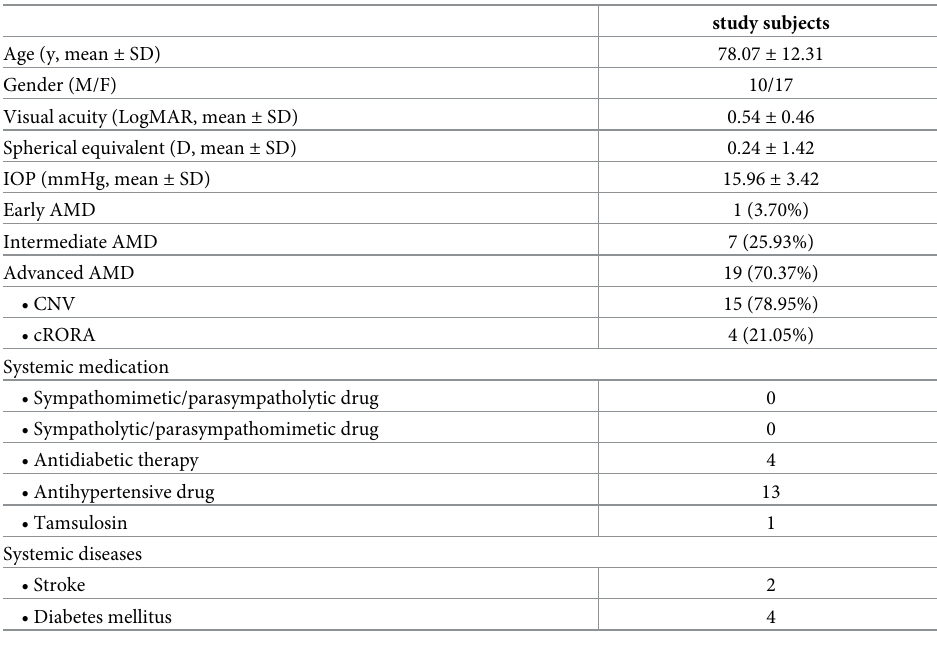
Table 1. Characteristics of study population.